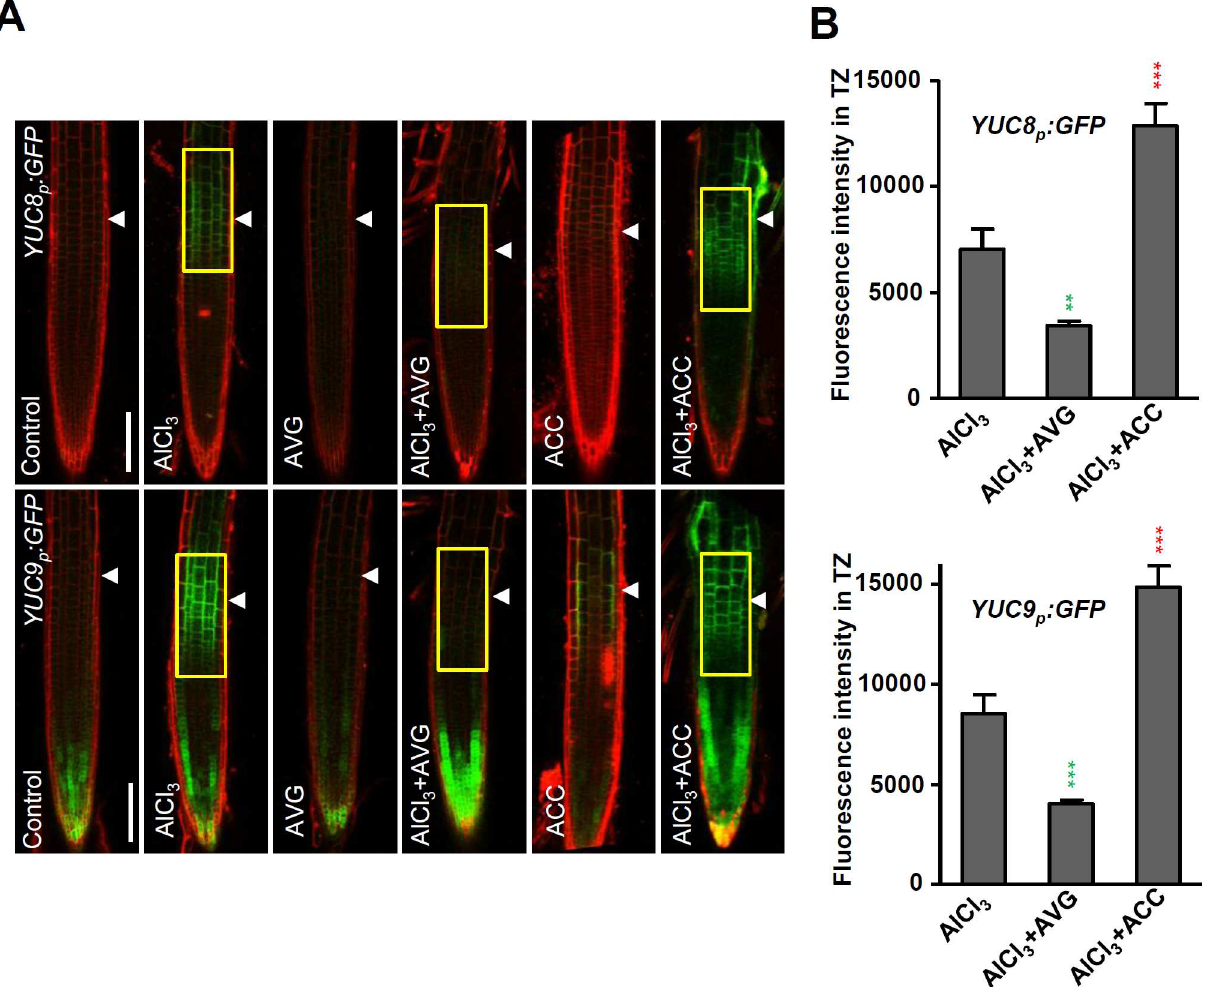
Fig 4. Al regulated local up-regulation of YUC s is ethylene dependent. (A) The expression of YUCp : GFP-GUS transgenesin the root- apex epidermisin presence of Al and either ACC or AVG. Three-day old transgenic YUCp : GFP-GUS seedlings were pre-treated with 1 μ M AVG or 1 μ M ACC for 1 day, then the seedlingswere treated with 1 μ M AVG or 1 μ M ACC in the presence or not of 25 μ M AlCl 3 for 2 hours. Cell boundariesappear red followingpropidiumiodide staining. The root- apex TZ is marked by white arrowheads.Scale bar: 100 μ m. (B) Quantification of the Al-inducedfluorescenceintensity in the TZ of YUC8p : GFP-GUS and YUC8p : GFP-GUS in (A). Around 30 seedlings were measured in each material. The detected fluorescenceregion in TZ is marked by yellow rectangles. Cell boundaries appear red followingpropidium iodide staining. Statistical difference from detected fluorescence is indicatedby asterisks (Fisher’s exact test, *** P <